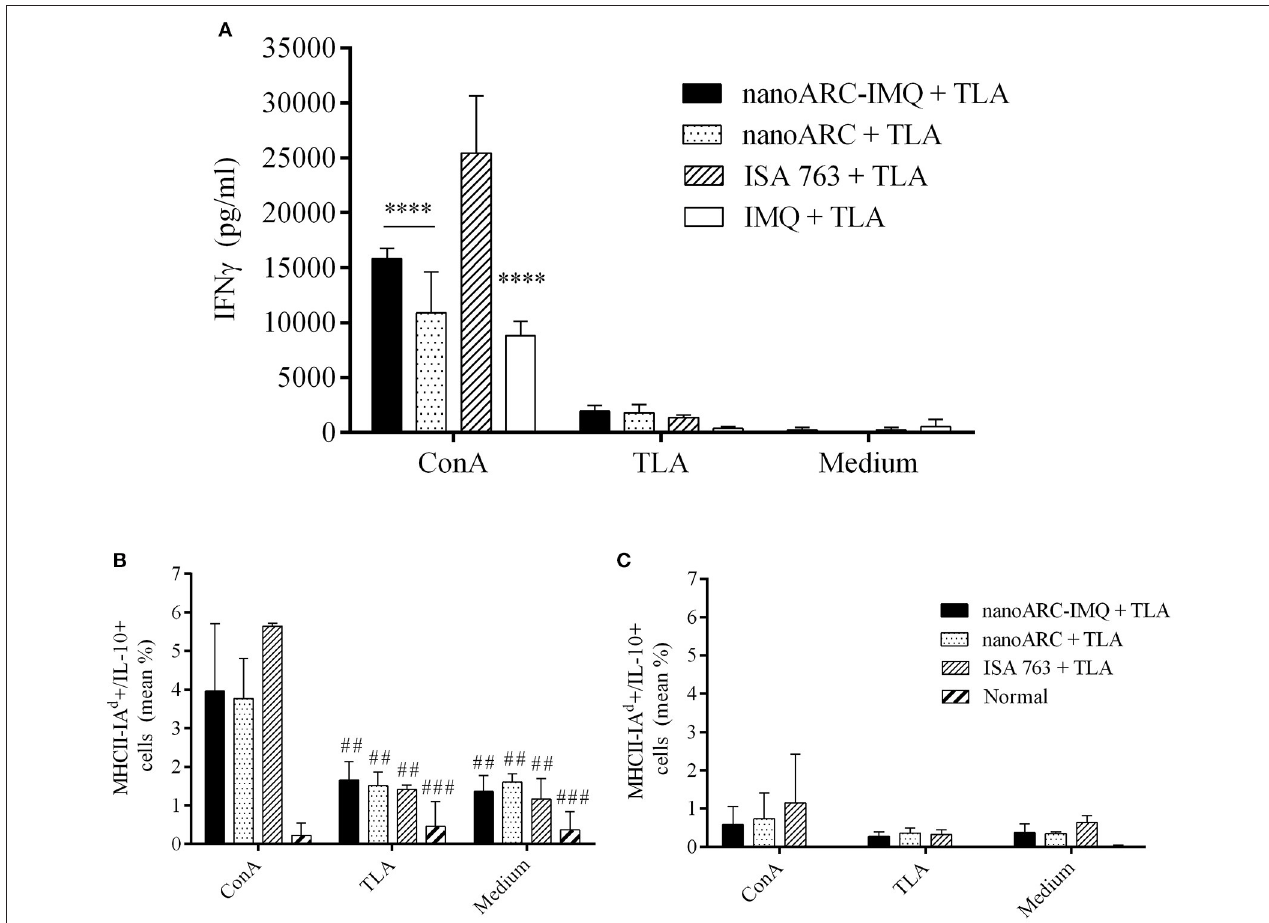
FIGURE 7 | (A) IFN- γ production and (B,C) cytoplasmic antibodies labeling IL-10 cytokines of splenocytes after 48h stimulation with concanavalin A, TLA or culture medium. (B,C) correspond to percentage media of activated cell [MHCII(I-A d ) + ] expressing IL-10 in the (B) monocytes and DCs and in (C) the lymphocytes regions, respectively. Asterisks indicate significant differences between ISA 763 + TLA and the reminder groups. Numerals indicate significant differences between ConA and TLA or medium. Values are expressed as mean ± SD ( n = 3 mice per